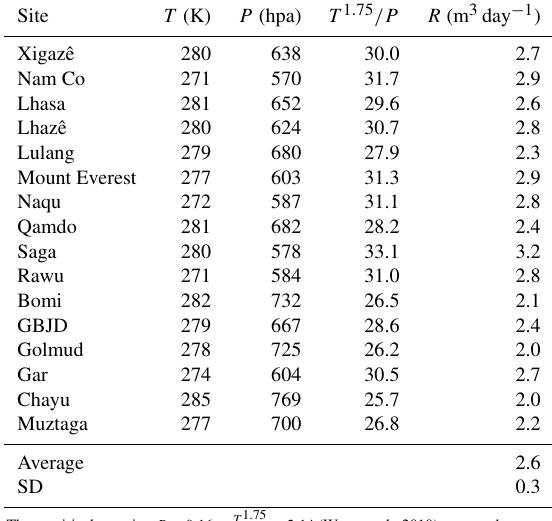
Table 2. Sampling rate ( R ) for 16 sampling